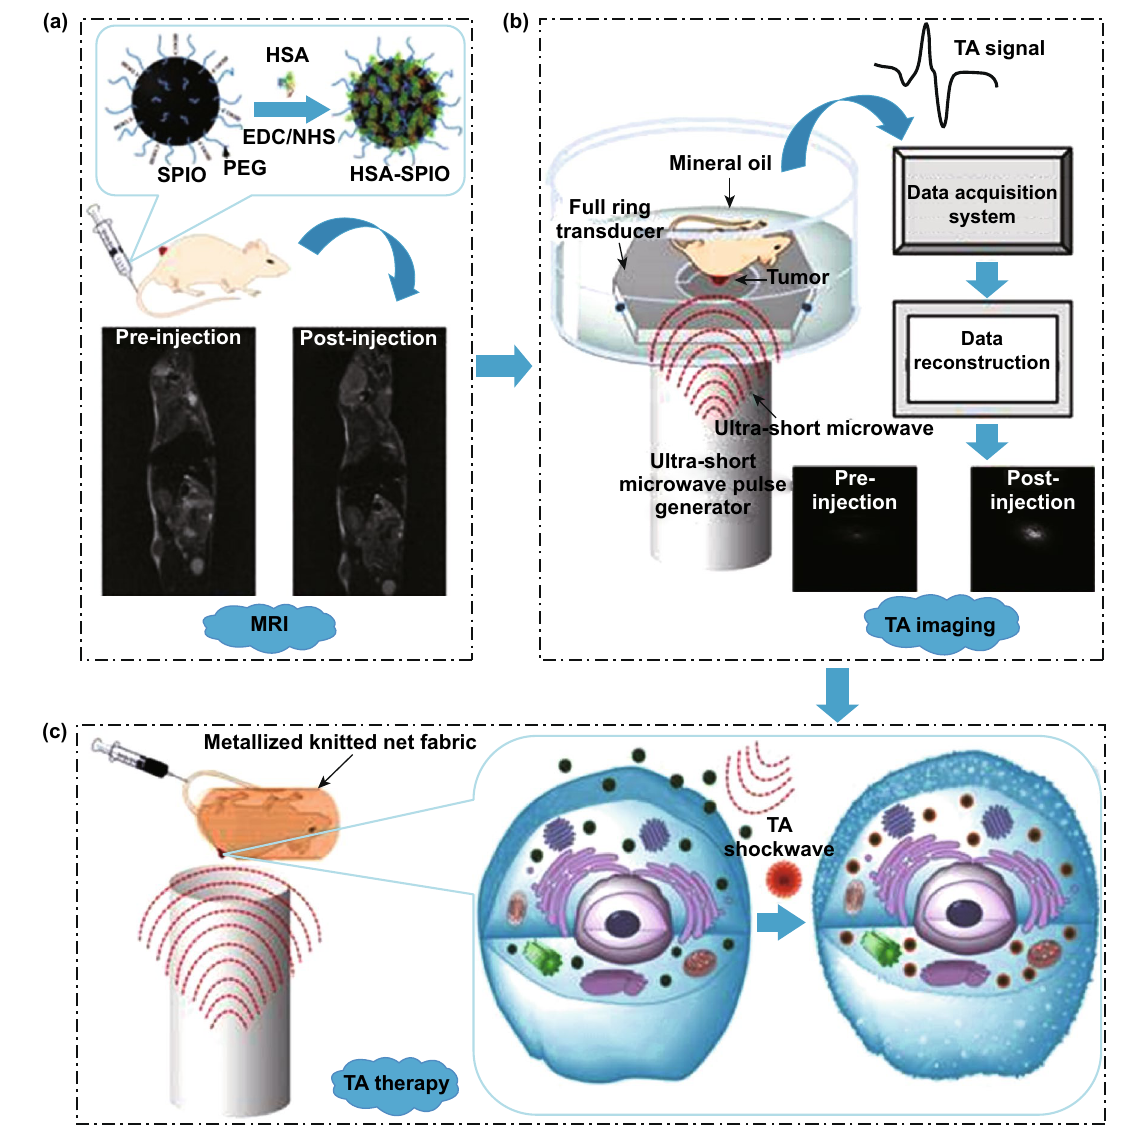
Fig. 6 Schematic illustrations of a the process of human serum albumin-coated iron oxide NPs (HSA-SPIO) synthesis and their administration to mice, b thermoacoustic (TA) imaging system, and c HSA-SPIO as therapeutic agent in synergy with MWs. Reprinted under a Creative